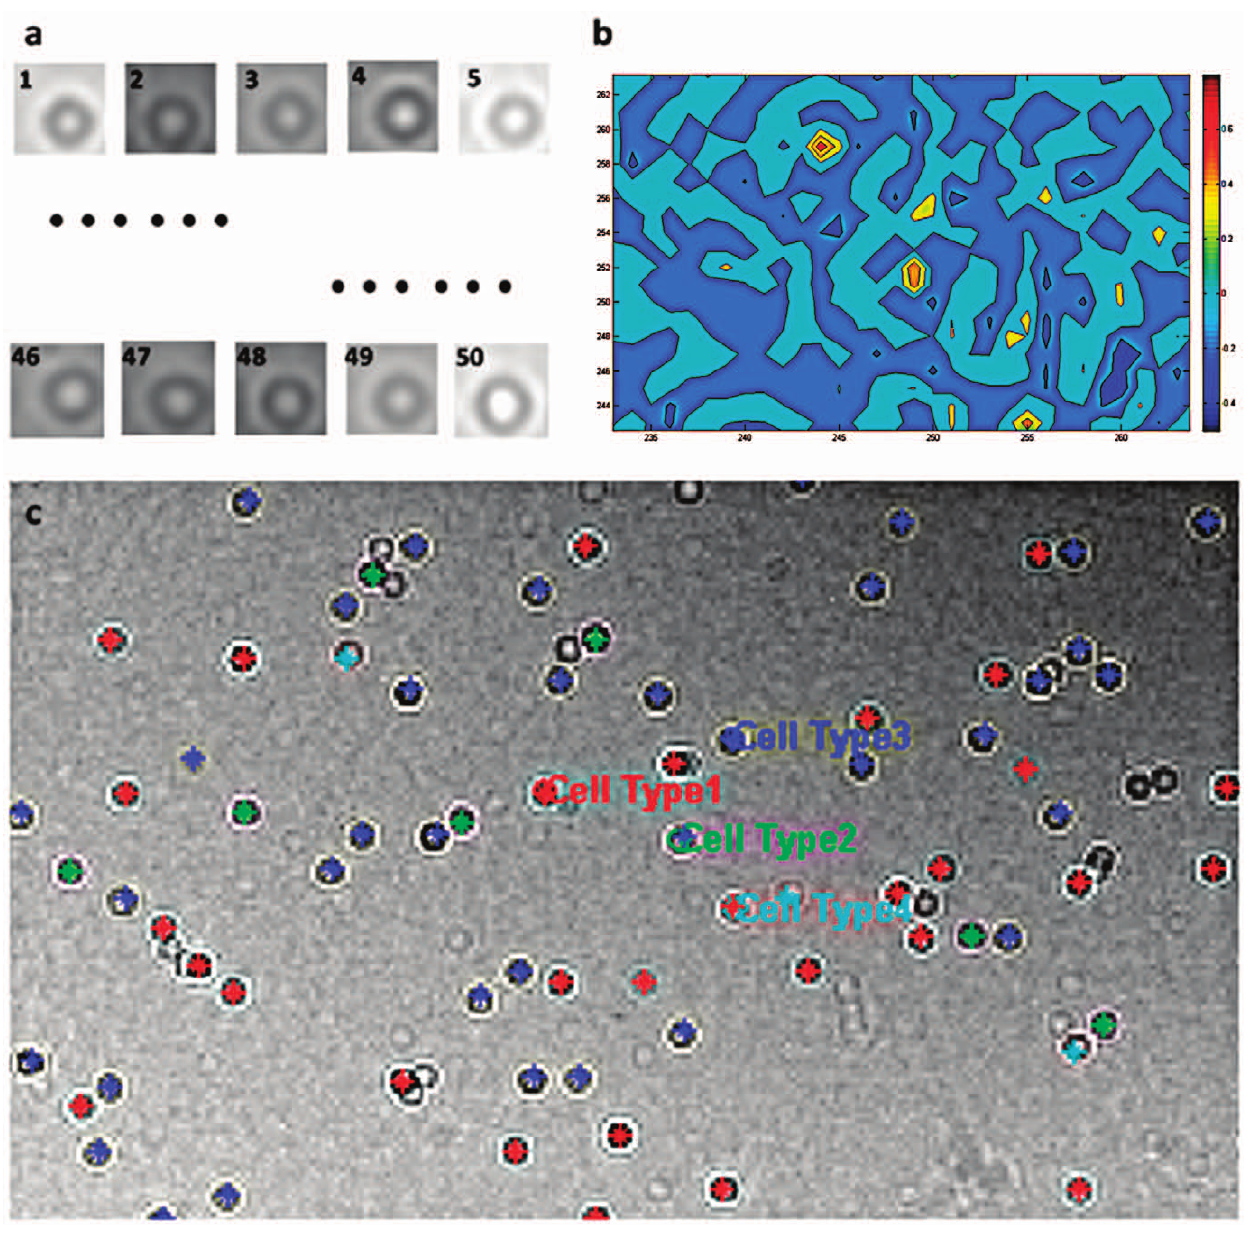
Figure 3. The typical output of automatic CD4 cell counting program based on pattern matching. ( a ) library images of cell types (a total 50 different images), ( b ) matching values compare an obtained shadow image and cell library images, ( c ) result of cell shadow image recognition using four different types of library cell patterns. The detected cells were marked with color coding to each library image that they were best matched using standard pattern recognition matching methods in MATLAB.